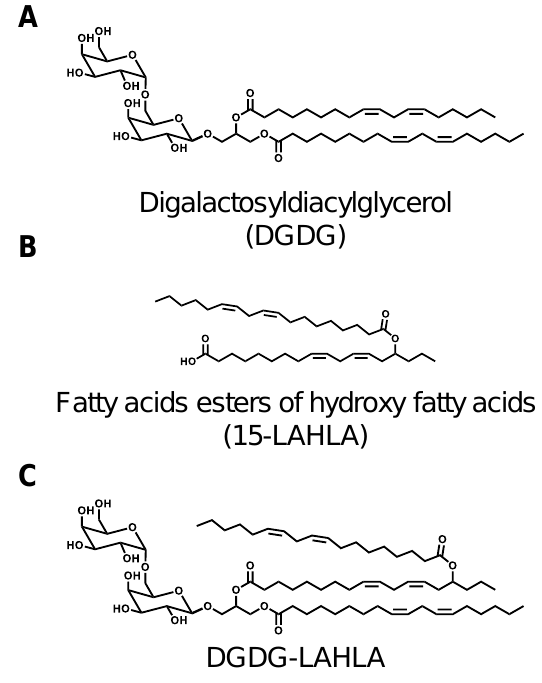
Figure 1. Chemical structures of ( A ) DGDG, ( B ) 15-LAHLA, and ( C ) DGDG-LAHLA. DGDG, digalactosyldiacylglycerol; LAHLA, linoleic acid ester of hydroxy linoleic acid.